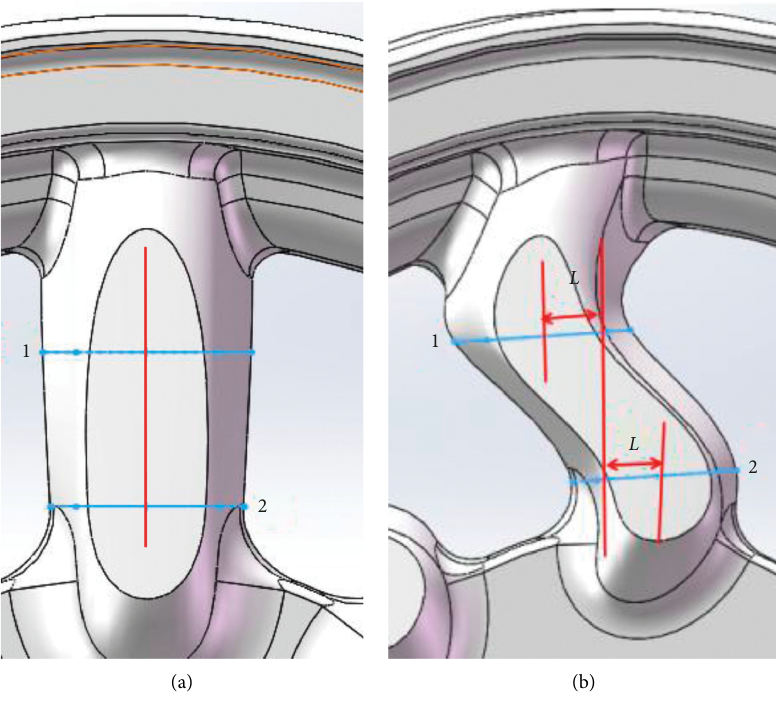
Figure 11: Structural optimization. Table 3: Wheel optimization.